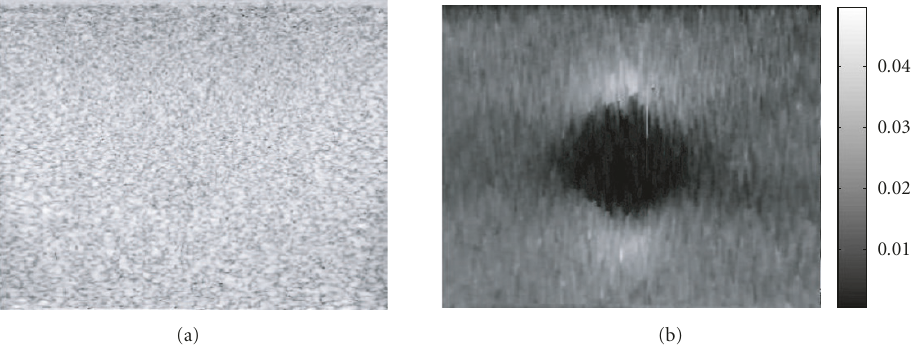
Figure 7: Application of the estimator on image of a sponge phantom within which is embedded a hard inclusion. (a) Ultrasound image of the phantom, (b) corresponding time-scaling factor distribution. The time-scaling factor in the inclusion is smaller, showing a harder elasticity in